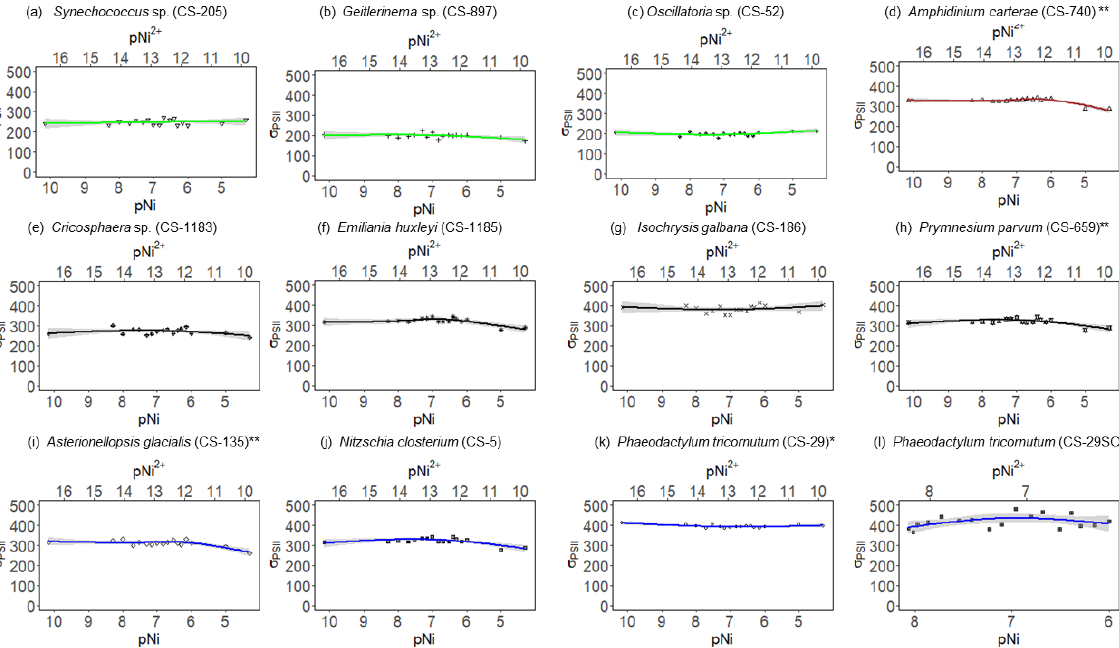
Figure 4. σ PSII results of phytoplankton cultures. p Ni and p Ni 2 + are the − log 10 transformed values of the total dissolved and free Ni 2 + concentrations (Eq. 1). A smaller value represents a higher concentration. The unit of σ PSII is nanometers squared (nm 2 ) per reaction center (RC). Plots (a) – (c) are cyanobacteria; plot (d) is a dinoflagellate; plots (e) – (h) are haptophytes; plots (i) – (l) are diatoms. Plots (a) – (k) were from strains growing in Aquil media, while plot (l) shows results for P. tricornutum growing in natural seawater media. Solid lines represent the smooth terms produced from GAM models using the growth rate data and p Ni concentrations. Shading indicates the 95% confidence interval. P values < 0.05 indicate that the smooth term is significantly different from a straight line. P values < 0.05 are indicated by ∗ , and P values < 0.01 are indicated by ∗∗